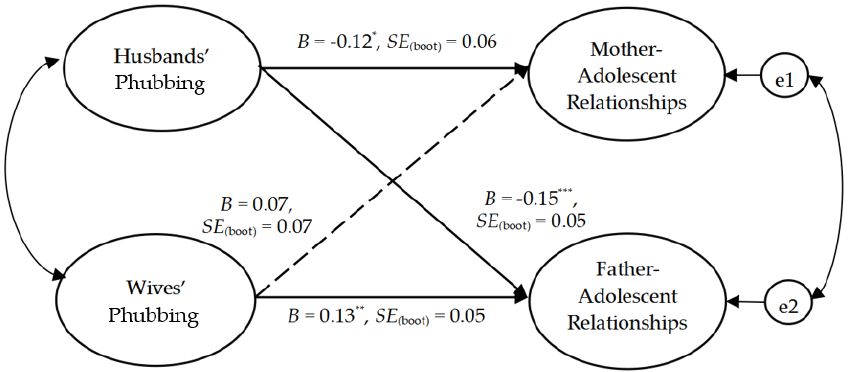
Figure 2. The dyadic model of the whole participants in the boy sample. Note. N = 249 couples. * p < 0.05, ** p < 0.01, *** p < 0.001. Dotted line indicates non-significant.